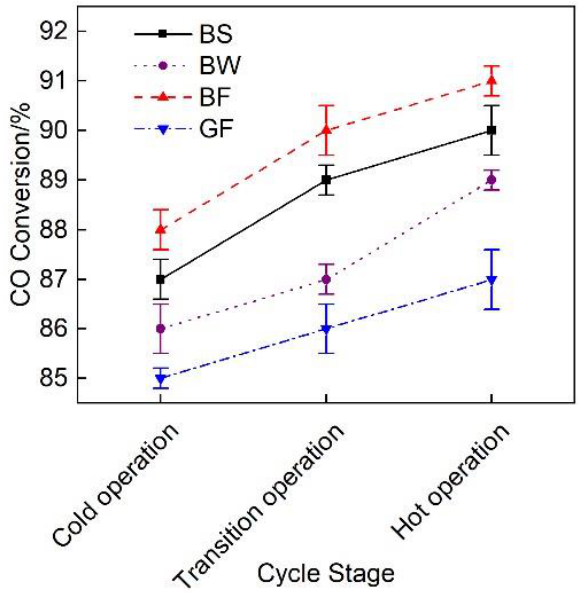
Figure 8. CO conversion rate of the different exhaust pipe covering schemes.